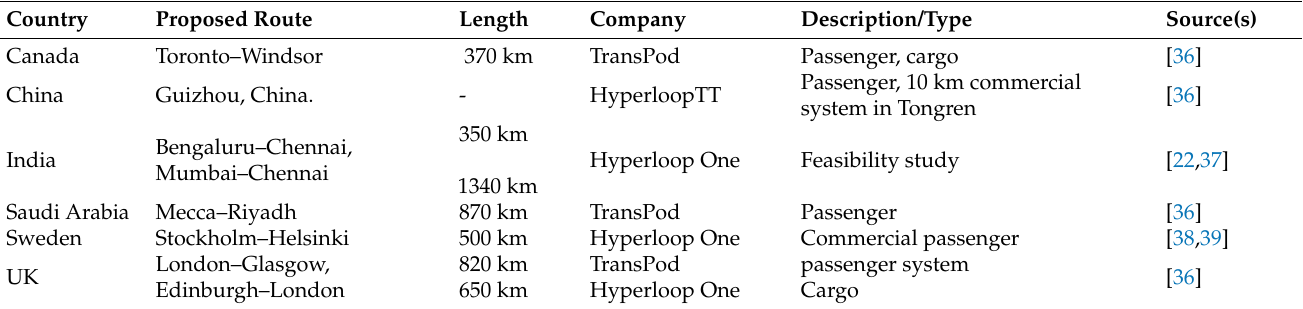
Table 1. Summary of proposed Hyperloop